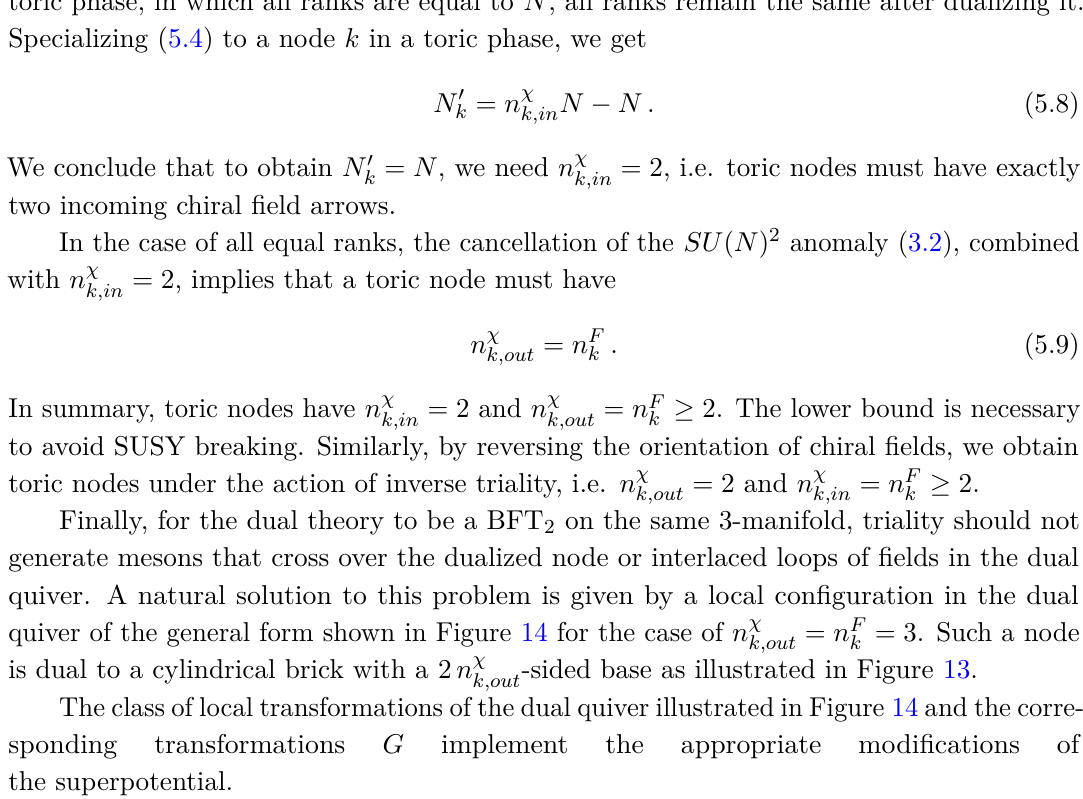
Figure 13 . Local configuration for a toric node with n χ The dotted lines may be attached to other faces and represent superpotential